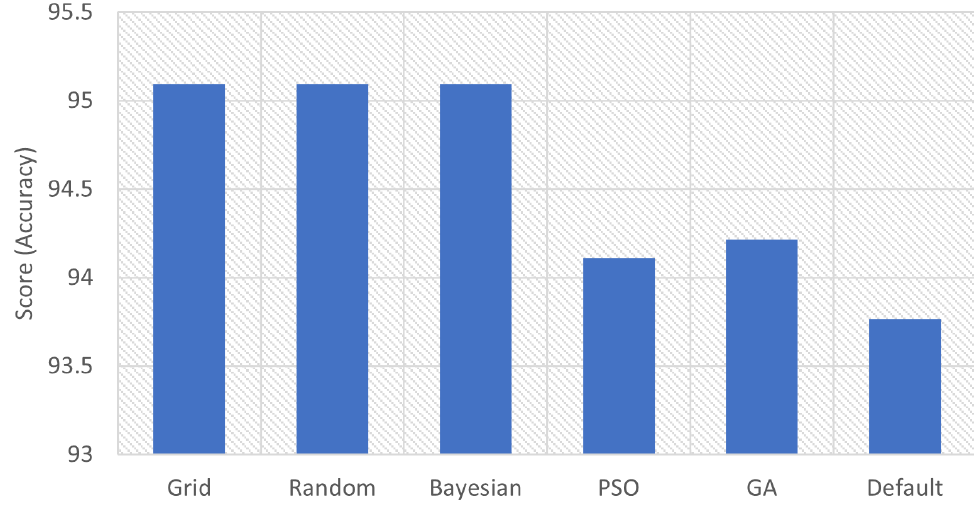
Figure 17. Hyperparameter tuning techniques versus score for Logistic Regression (LR).